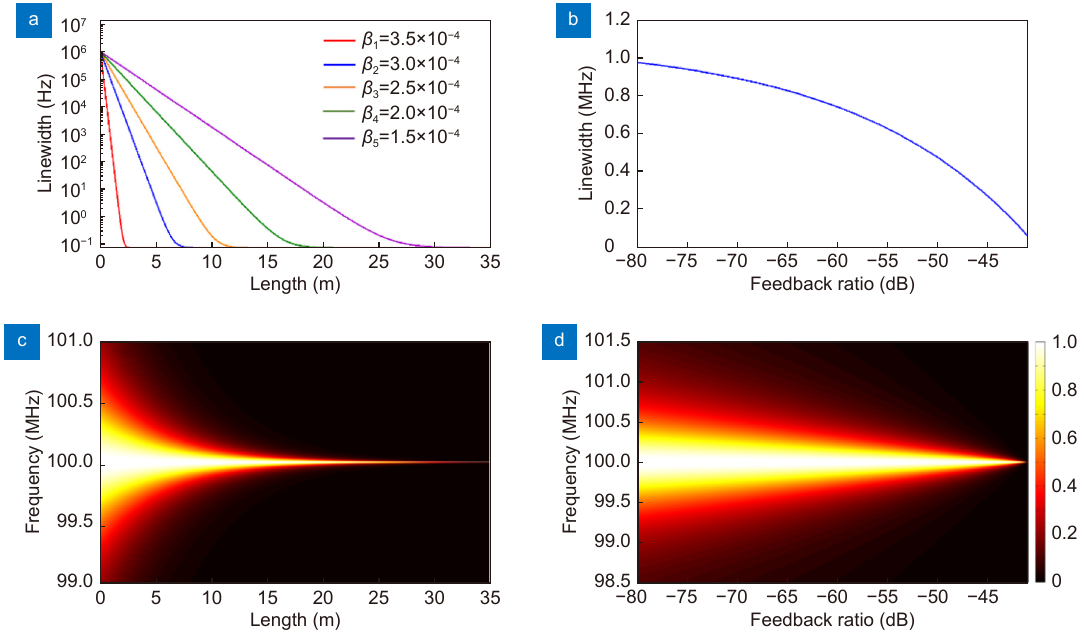
Fig. 2 | Simulation results of laser linewidth evolution. ( a ) Output linewidth evolution with the feedback length under different feedback coeffi- cients. ( b ) Linewidth curve at the different feedback ratios. Two-dimensional pseudocolor maps of the spectra vary ( c ) with the length and ( d ) with feedback